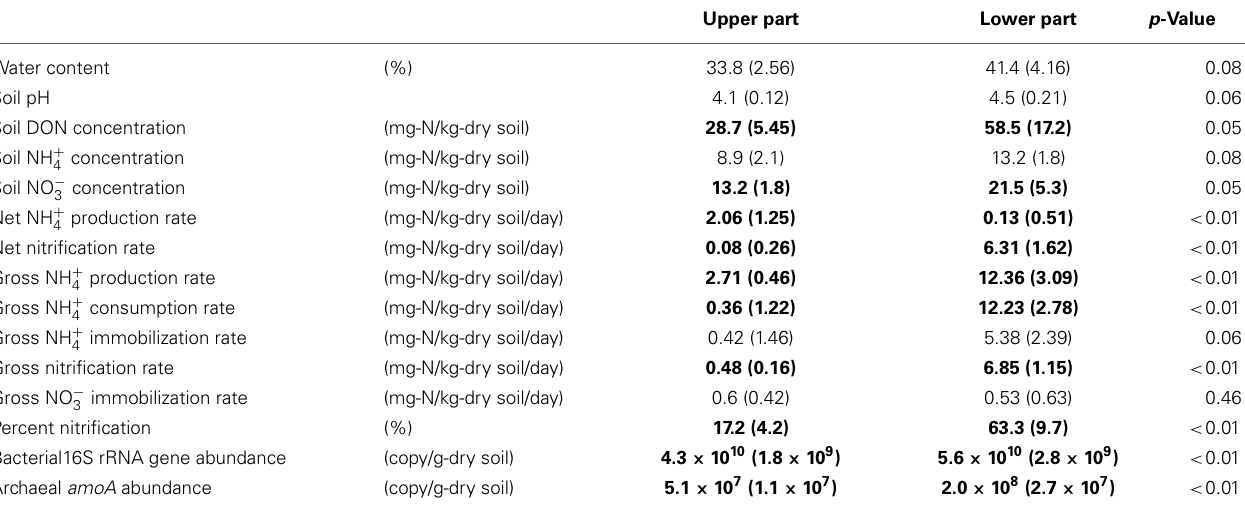
Table 1 | Soil properties, N transformation rates, and gene abundances in upper and lower parts on the forest